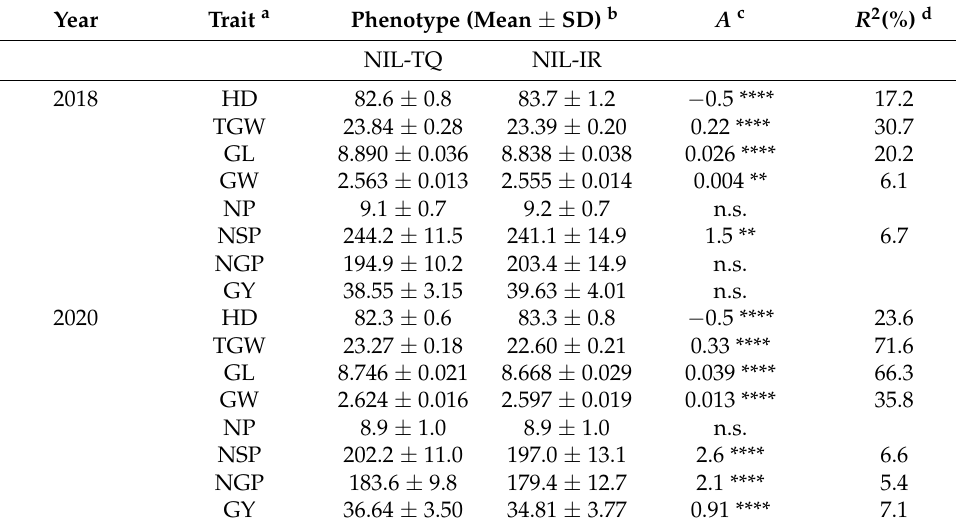
Table 1. Effects of OsMADS56 detected in near-isogenic